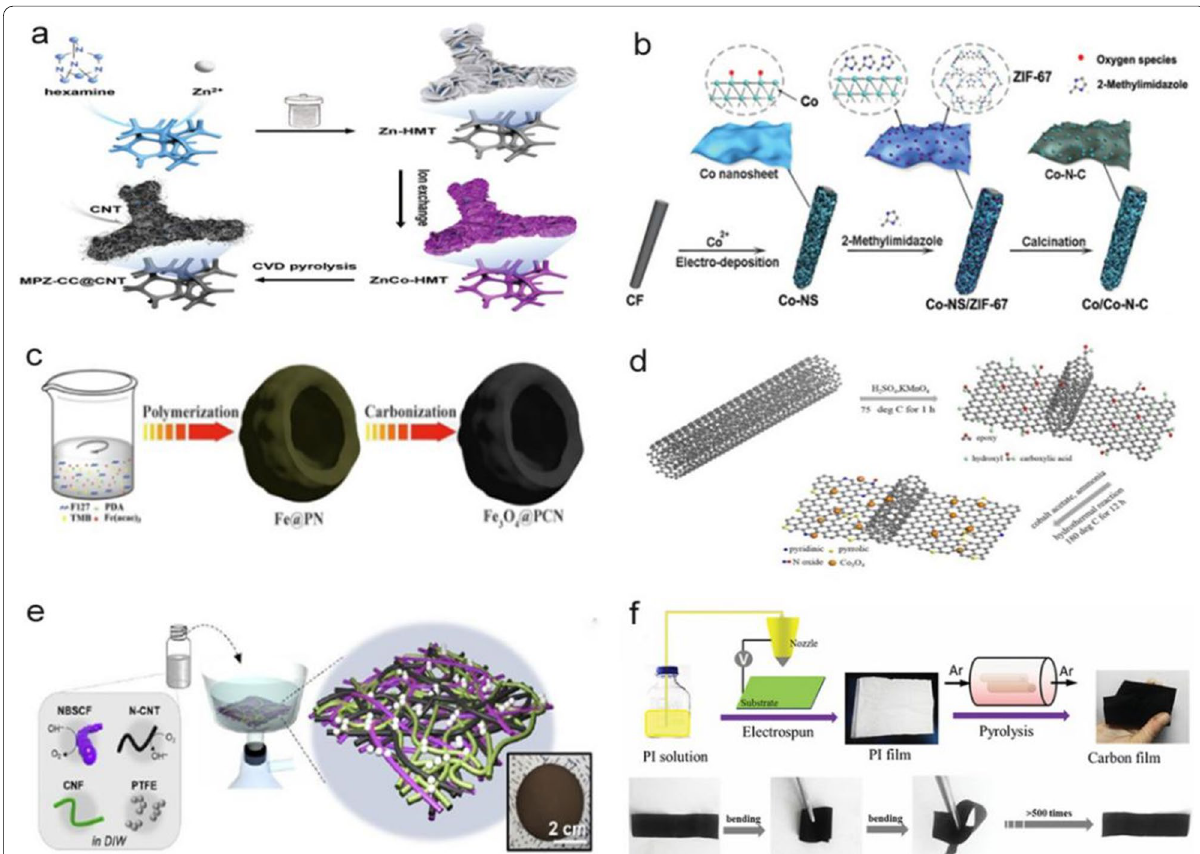
Fig. 2 a Schematic of the preparation process for MPZ-CC@CNT [28]. b Synthesis of the Co/Co–N-C catalyst [29]. c Schematic of the preparation of the